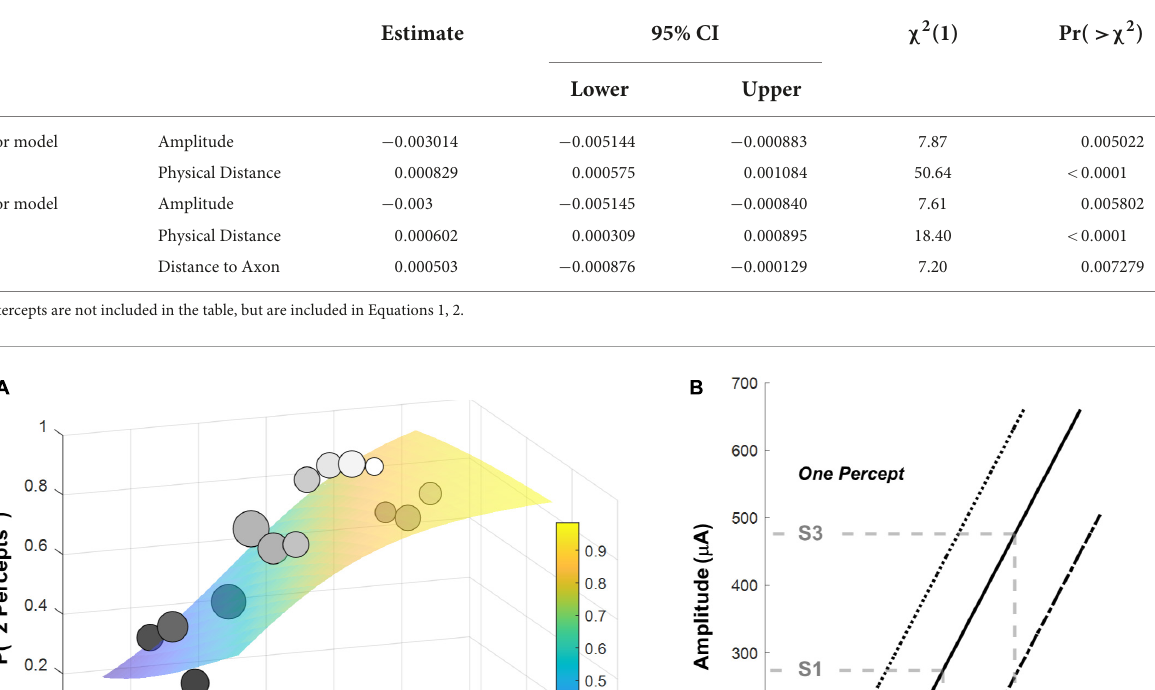
TABLE 6 Logistic regression model parameters and statistical significance.